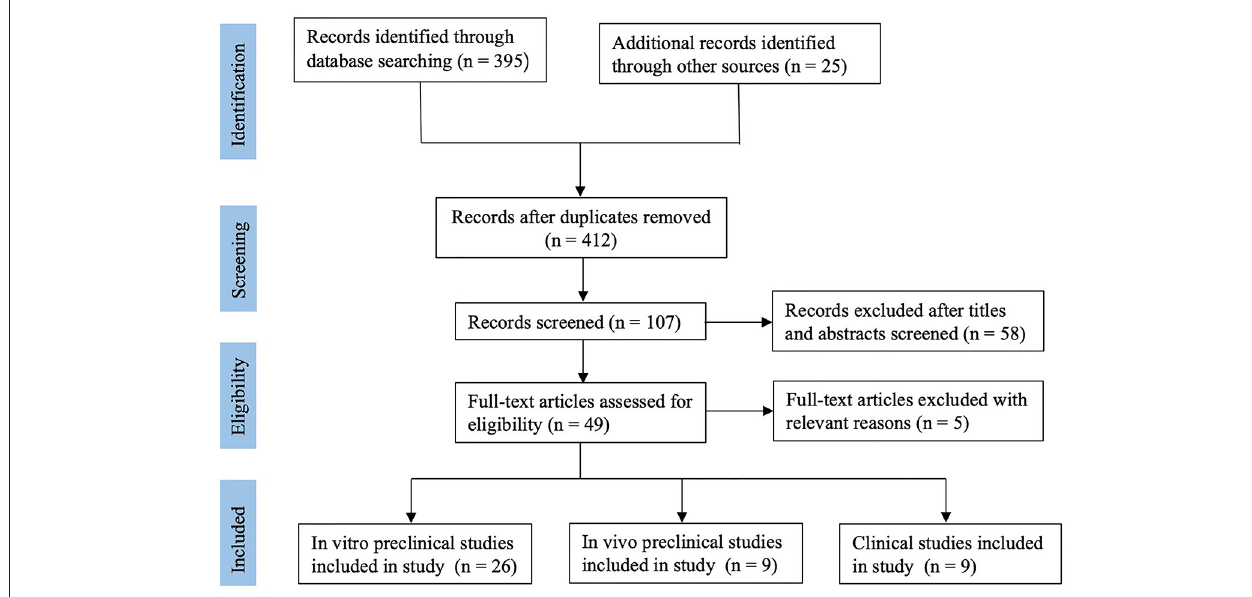
FIGURE 1 | Flow chart of study selection.